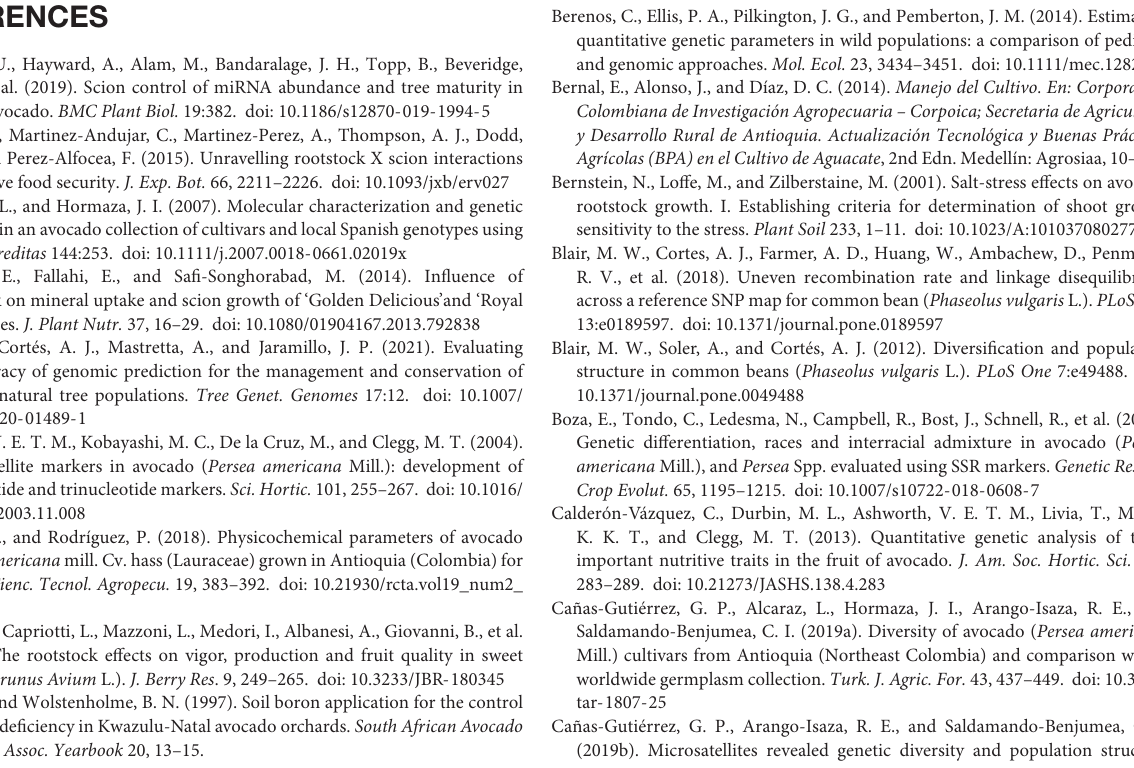
Supplementary Figure 1 | Distance tree computed by means of Neighbor Joining algorithm in R with 10,000 bootstrap replicates.